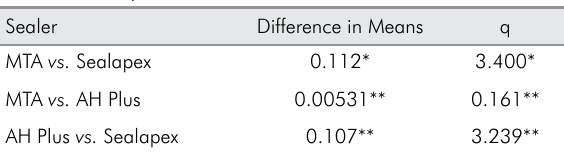
Table 2. Tukey test.